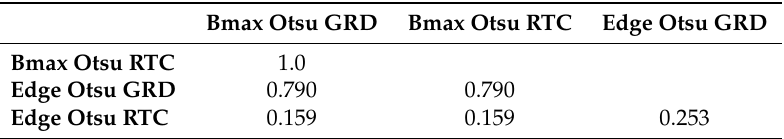
Figure 4. Accuracy assessment for the two algorithms (Bmax Otsu and Edge Otsu) using the two datasets (GRD and RTC) showing the distribution of ( a ) overall accuracy, ( b ) precision/recall ratio, ( c ) Cohen Kappa coefficient, and ( d ) F-1 score. The violin plots show the distribution of values at different accuracy scores. The thicker the violin, the more values fall at the y value. Table 3. Statistical significance testing scores using McNemar’s test. First row is the method compared against the method from the first column. Values are p -value of test where higher values mean that null-hypothesis, there no difference in the accuracy, has a higher probability of being true. Values less than 0.05 are statistically